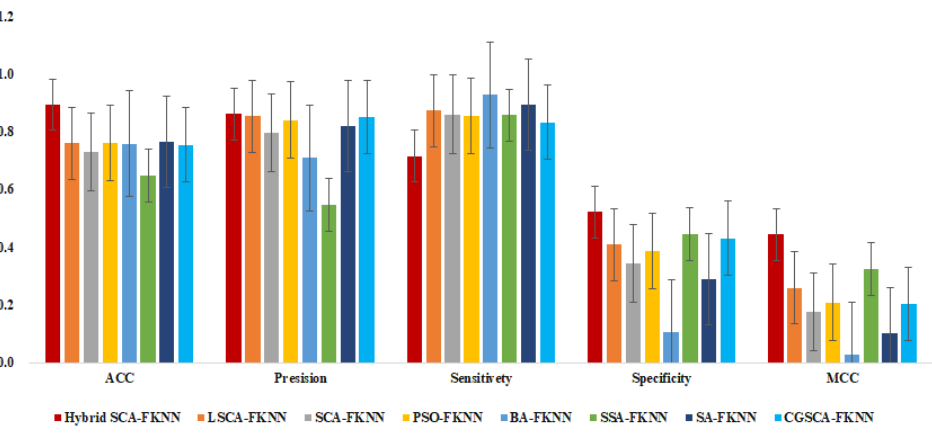
Figure 7. Classification performance of each model on the SPECT